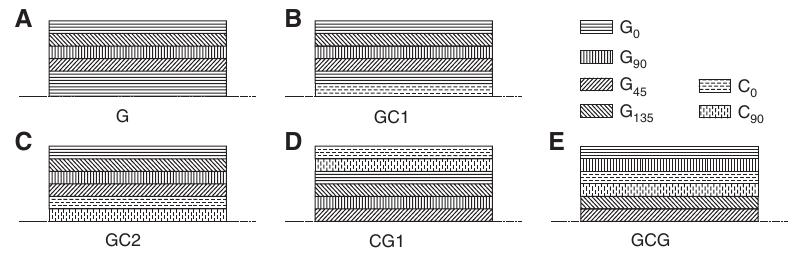
Figure 1: Schematic representation for top half of symmetric laminates.